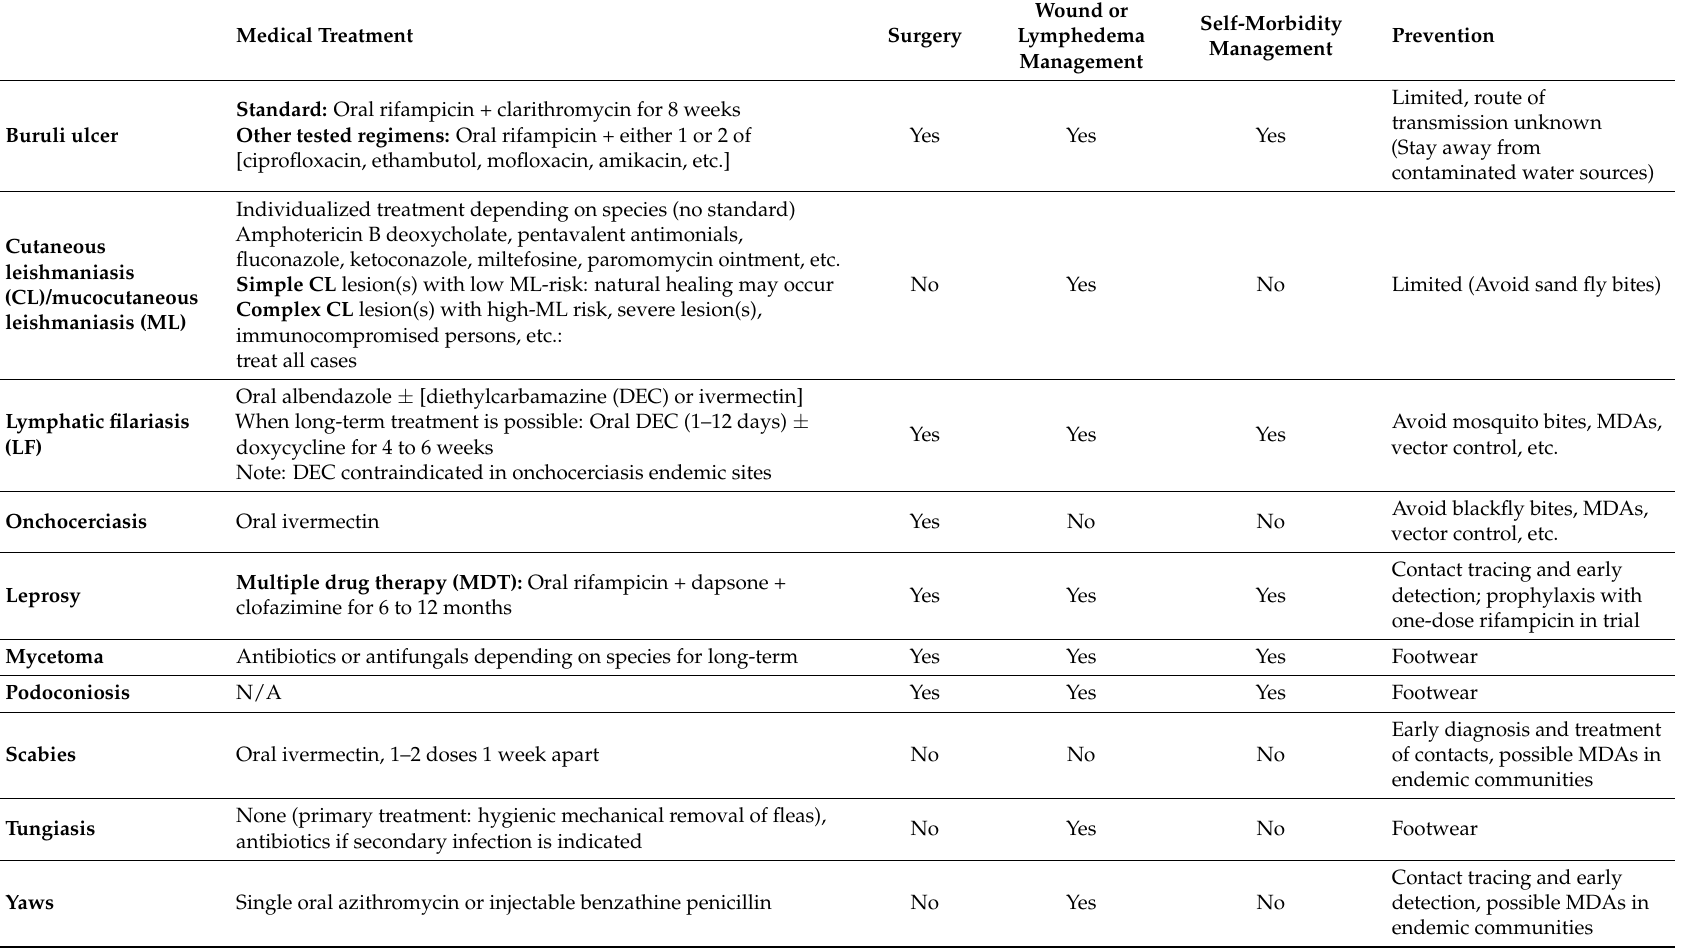
Table 2. Treatment and management for skin